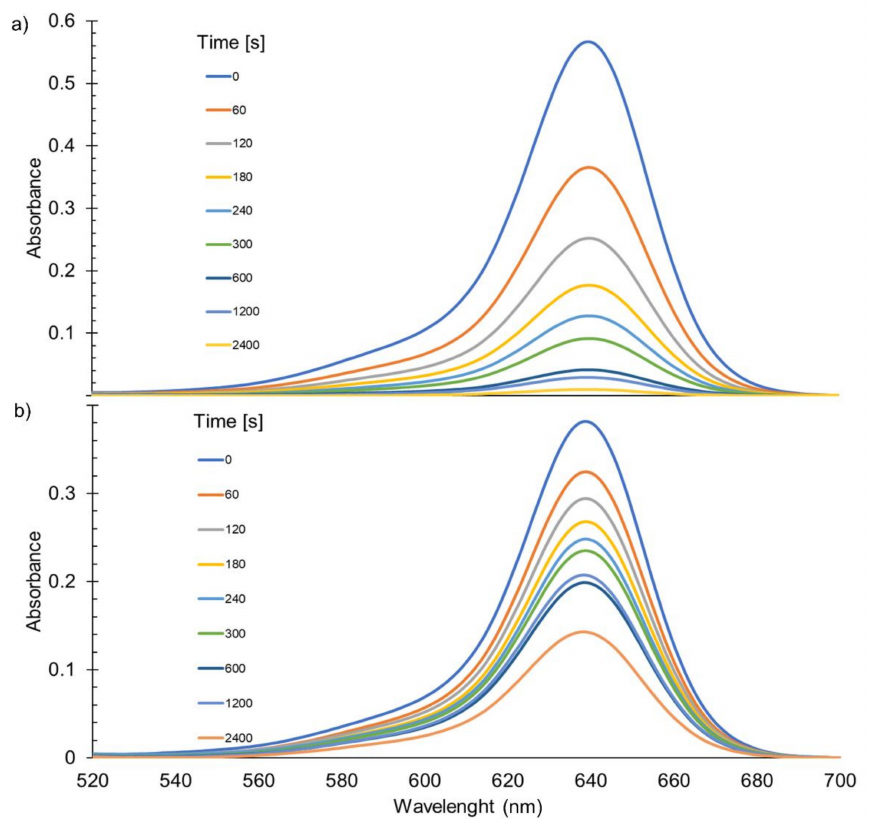
Figure 8. Changes in UV-Vis absorption spectra of DMASQ ( a ) and CS + 2% DMASQ ( b ) solutions (in acetic acid/methanol 1:1 v/v) during UV-exposure.